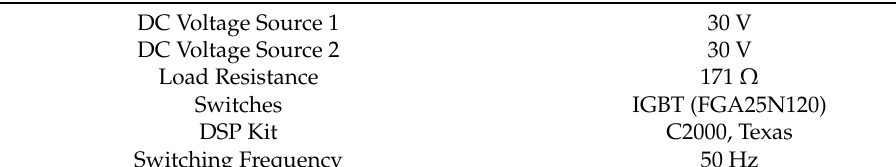
Table 11. List of experimental parameters.